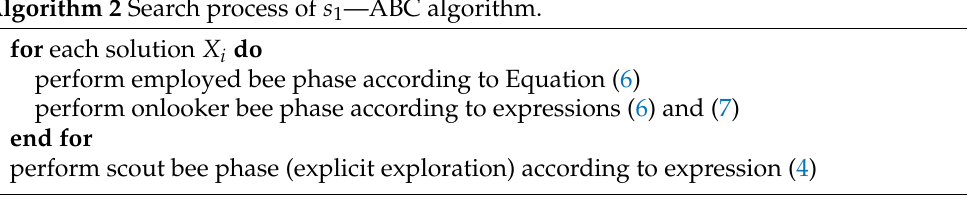
Algorithm 2 Search process of s 1 —ABC algorithm.